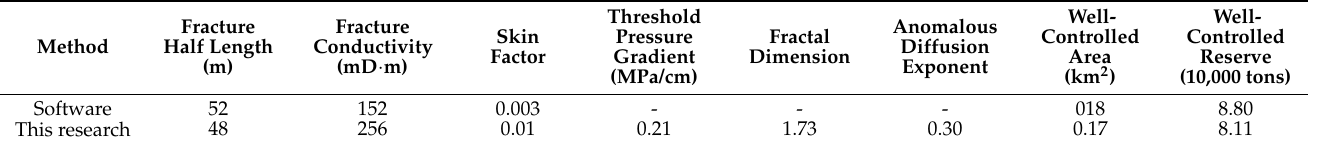
Table 2. Interpretation